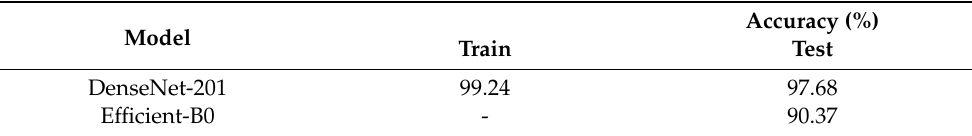
Figure 7. The CMC curves for the feature extracted from the last convolution layer of different backbone model using UFPR dataset. Table 5. Performance comparison of using DenseNet-201 and Efficientnet-B0 as backbone model for LDA-CNN model. The results were obtained using UFPR